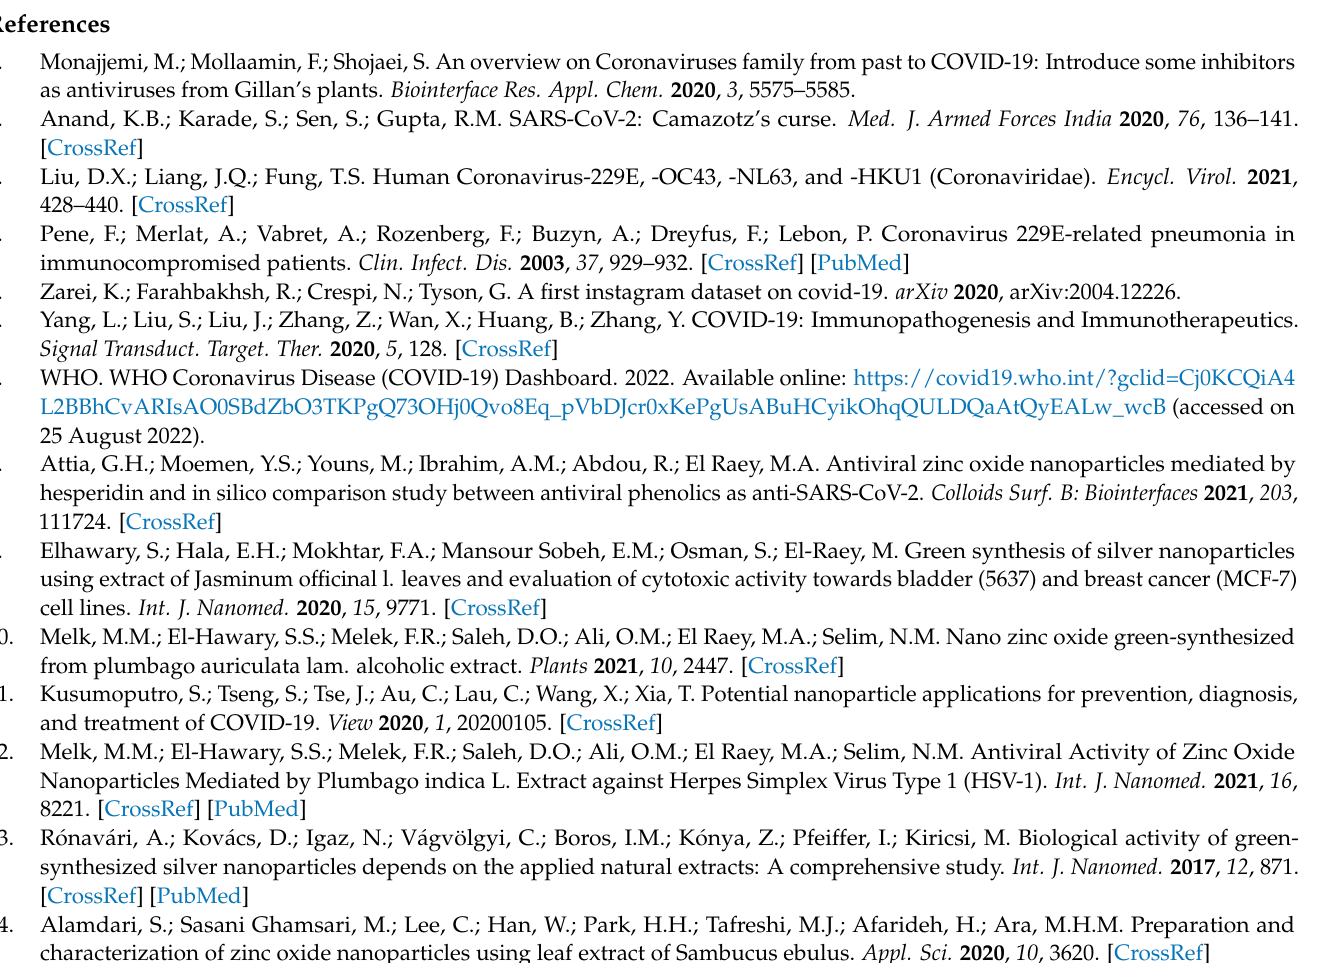
− 25.1. Figure S3: Effect of pH on ZnO-NPs at different time